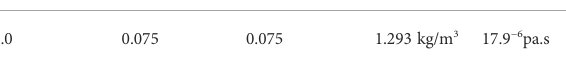
TABLE 4 Aggregate- mortar contact parameters.